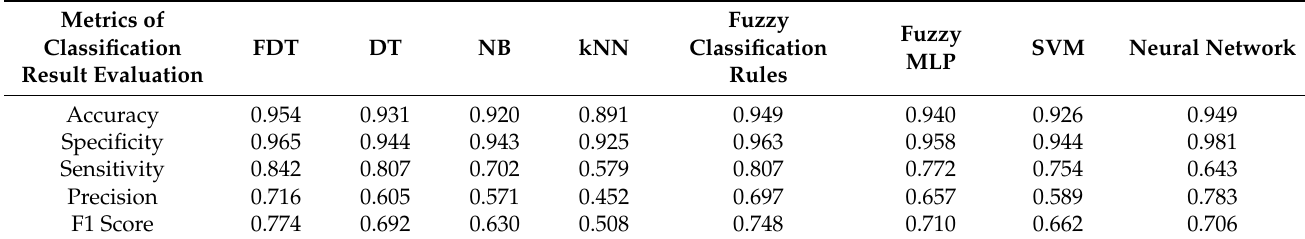
Table 8. Comparison of the classification algorithms for evaluation of patients with COVID-19. Metrics of